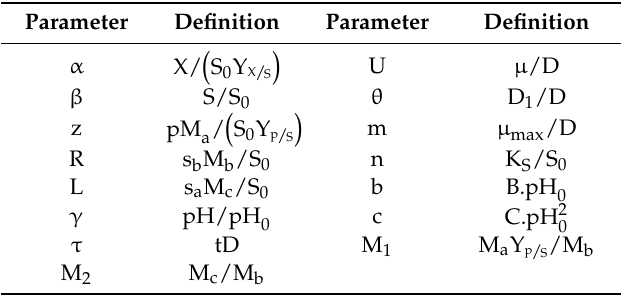
Table 3. Definitions of the dimensionless variable used in the